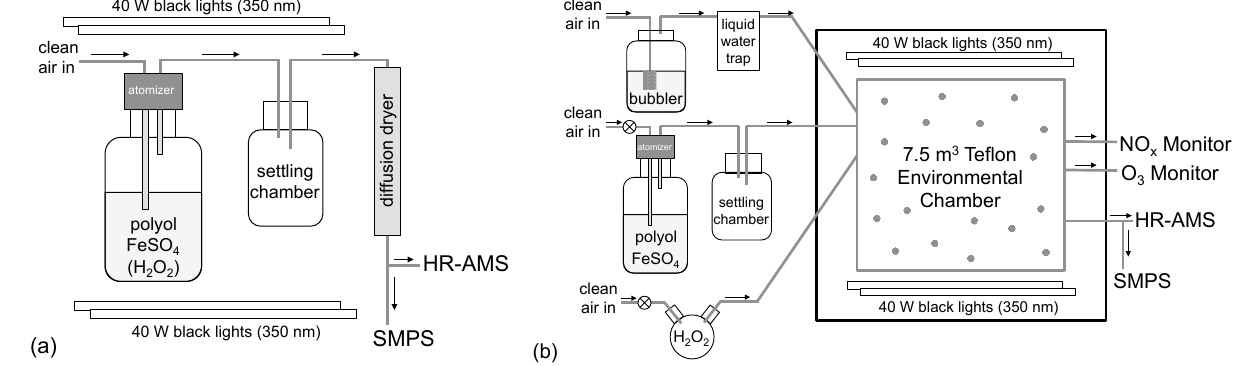
Figure 2. Experimental setup for (a) bulk experiments and (b) chamber experiments. The atomizer serves as a reactor for bulk oxidation but only as a source of aqueous particles for chamber oxidation. In the bulk experiments, the solution is continuously atomized, with H 2 O 2 added after the polyol and FeSO 4 have been sampled for 1h. In the chamber experiments, a solution containing the polyol and FeSO 4 is atomized into the chamber for 1h, with gas-phase H 2 O 2 introduced later via the two-neck flask. Humidified makeup air is continuously supplied to the chamber via the bubbler. While the focus of this work is dark Fenton chemistry, UV lights are turned on following oxidation in both setups in order to assess the photoreactivity of the reaction